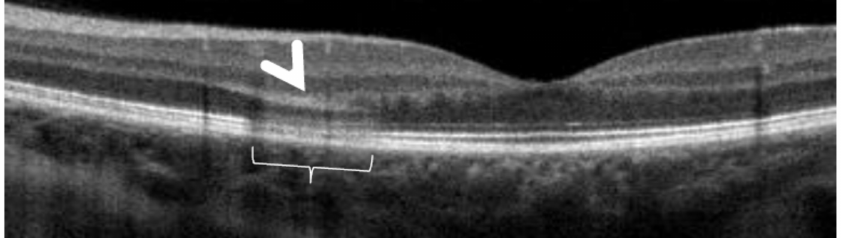
Figure 30. AMN. SD-OCT image performed one day after the onset of symptoms. SD-OCT shows a highly reflective band at the level of the OPL/ONL (arrowhead), resembling Paracentral Acute Middle Maculopathy (PAMM) with alterations of EZ and IZ lines (bracket).